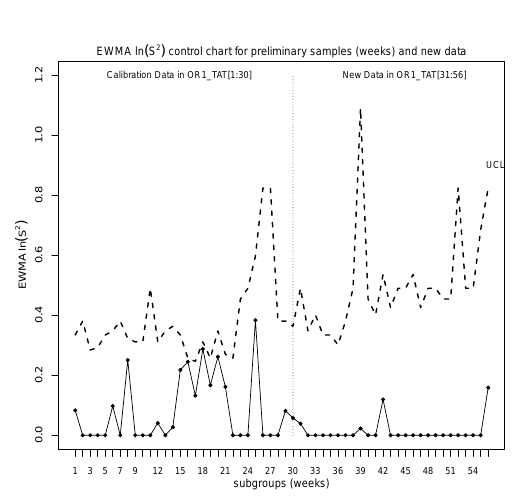
Figure 5 – EWMA control chart for the standard deviation: preliminary samples (Cali- bration from week 1 to week 30); new observations (from week 31 to week 56)